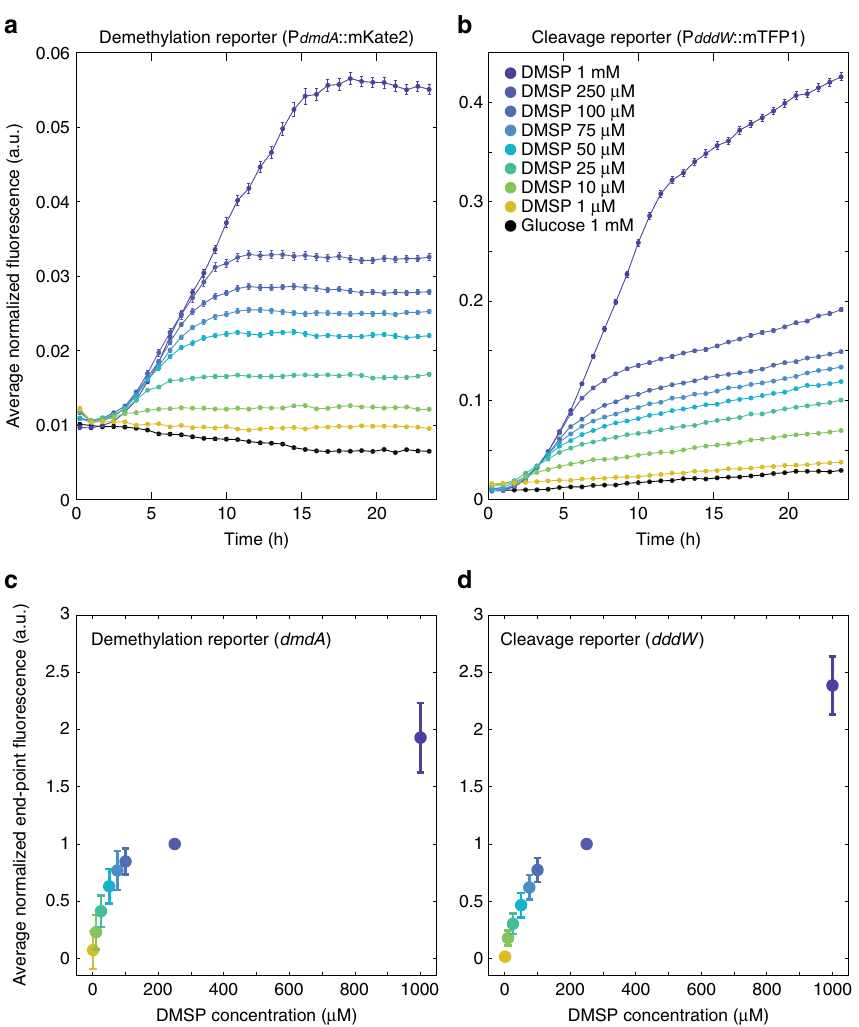
Fig. 2 DMSP concentration-dependent upregulation of dmdA and dddW . a , b Mean fl uorescence signals of dmdA (demethylation) ( a ) and dddW (cleavage) ( b ) reporters in response to different concentrations of DMSP. One representative replicate experiment of reporter strain Goofy is shown (data from additional replicate experiments ( n = 3 for each reporter strain) are shown in Supplementary Fig. 6). Spectral leakage correction, background subtraction, and a threshold on YFP intensity were applied (see Methods and Supplementary Note 1). RFP and TFP signals of each cell were normalized by the mean YFP signal at each time point of each experimental condition. Data points and error bars represent means± s.e.m. of cells (error bars may be smaller than markers). c , d Average end-point fl uorescence levels of dmdA ( c ) and dddW ( d ) reporters. For each replicate experiment, baseline signal (glucose) was subtracted at each time point, fl uorescence signals over the fi nal fi ve time points (~20.4 – 24 h) were averaged, then normalized by the corresponding end-point fl uorescence signal at 250 μ M DMSP. Data points and error bars represent means ± s.d. of six total replicates ( n = 3 for strain Regular and n = 3 for strain Goofy